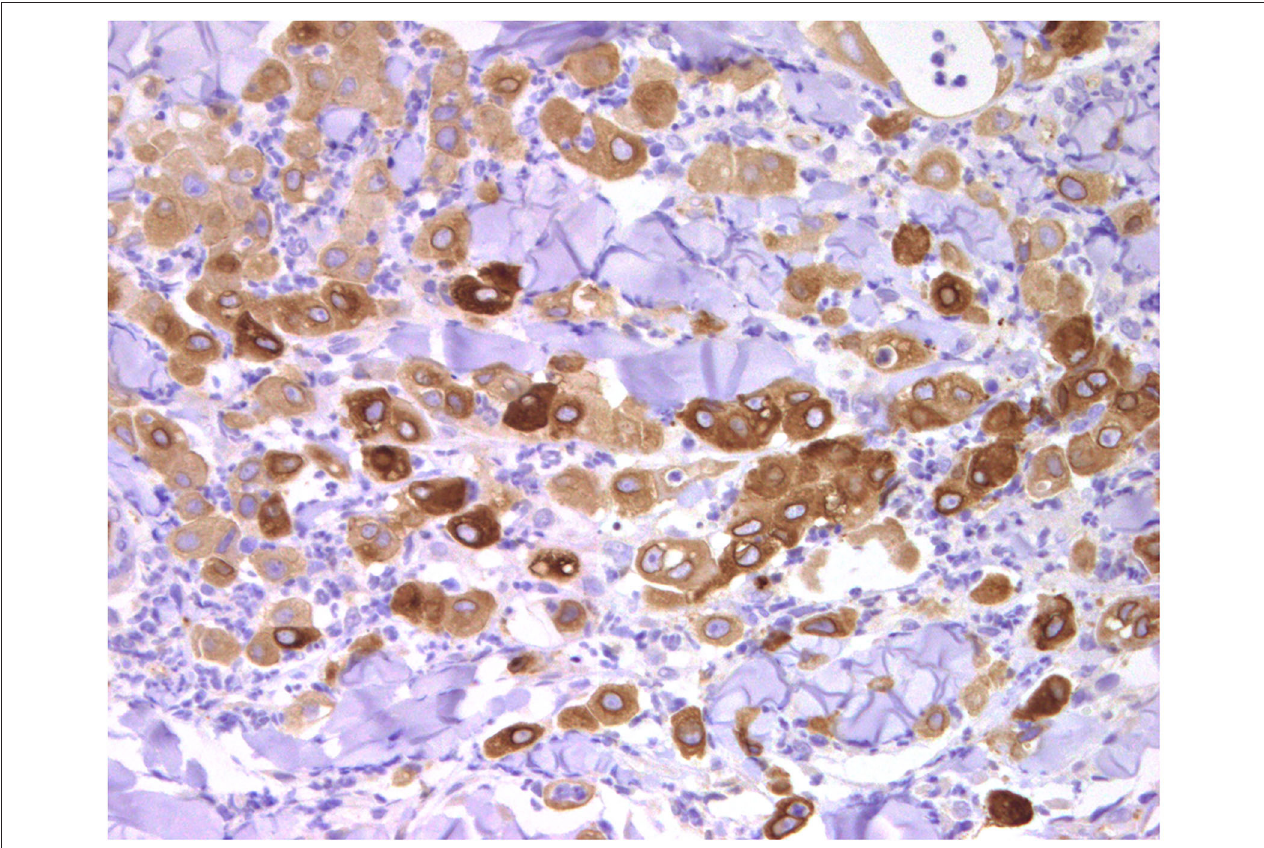
FIGURE 11 | Anaplastic carcinoma, mammary gland, dog, inflammatory carcinoma. Immunohistochemical cytoplasmic staining of cyclooxygenase-2 (COX-2). Neoplastic cells are positive with different intensities of